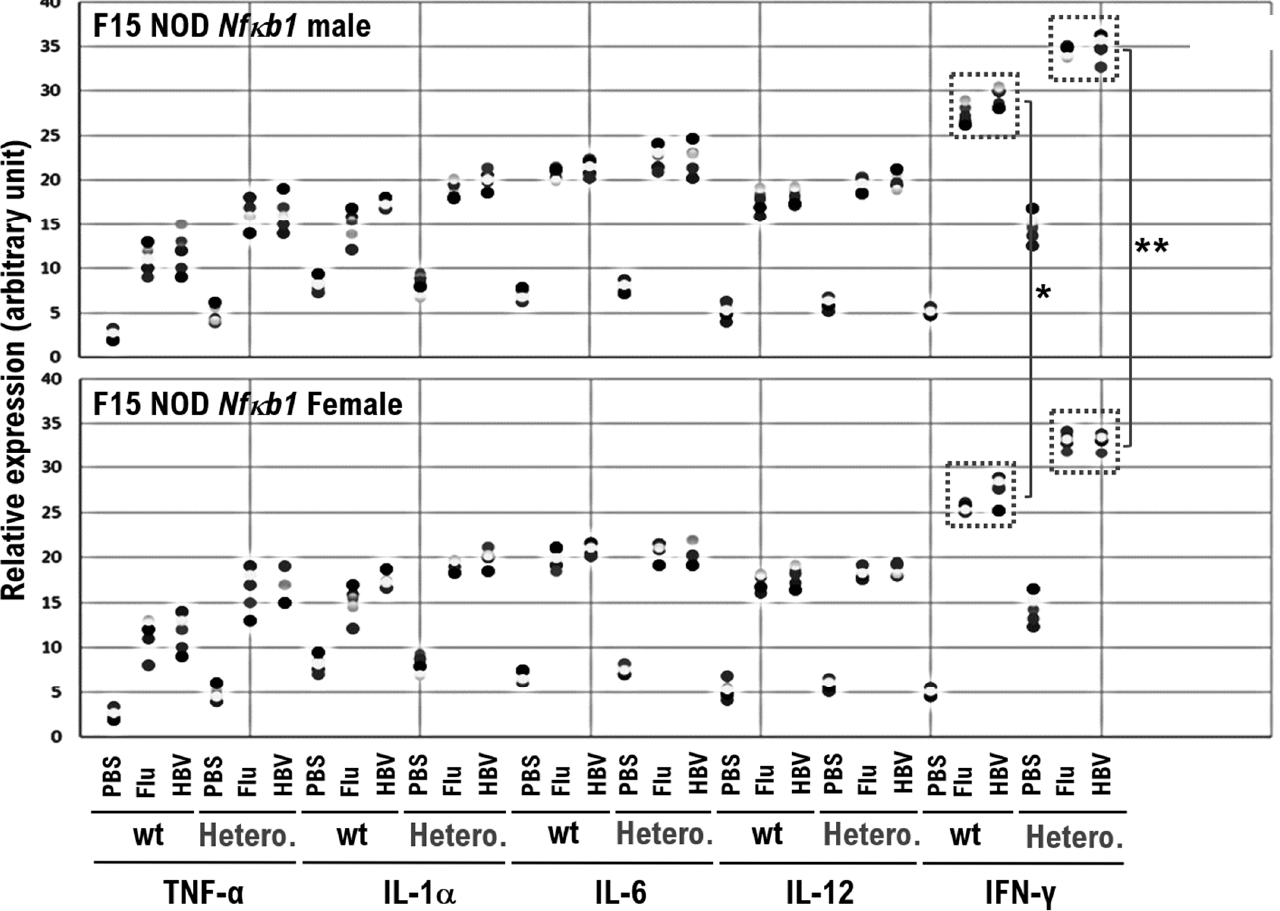
48 h of coculture, the CD8-positive T-cell proliferation was assessed using the BrdU cell